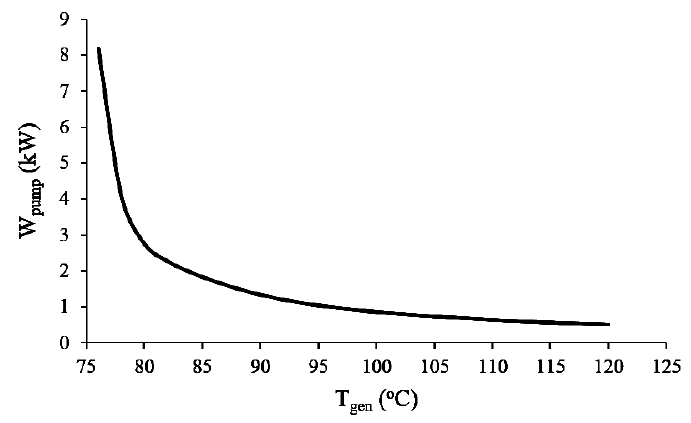
Figure 9. Effect of T gen on pumping power.